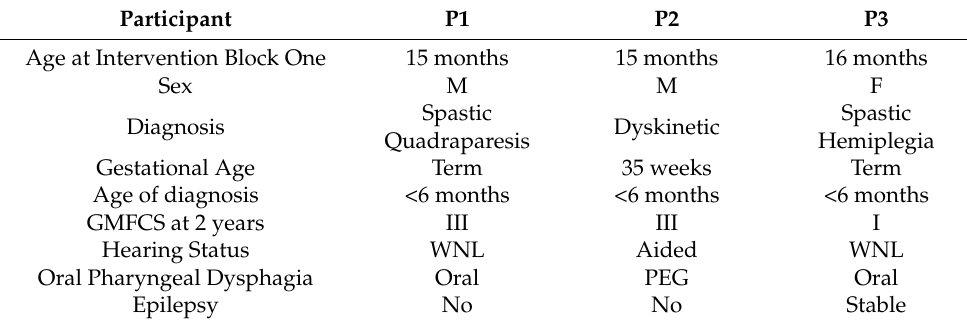
Table 1. Participant Characteristics at Study Onset.